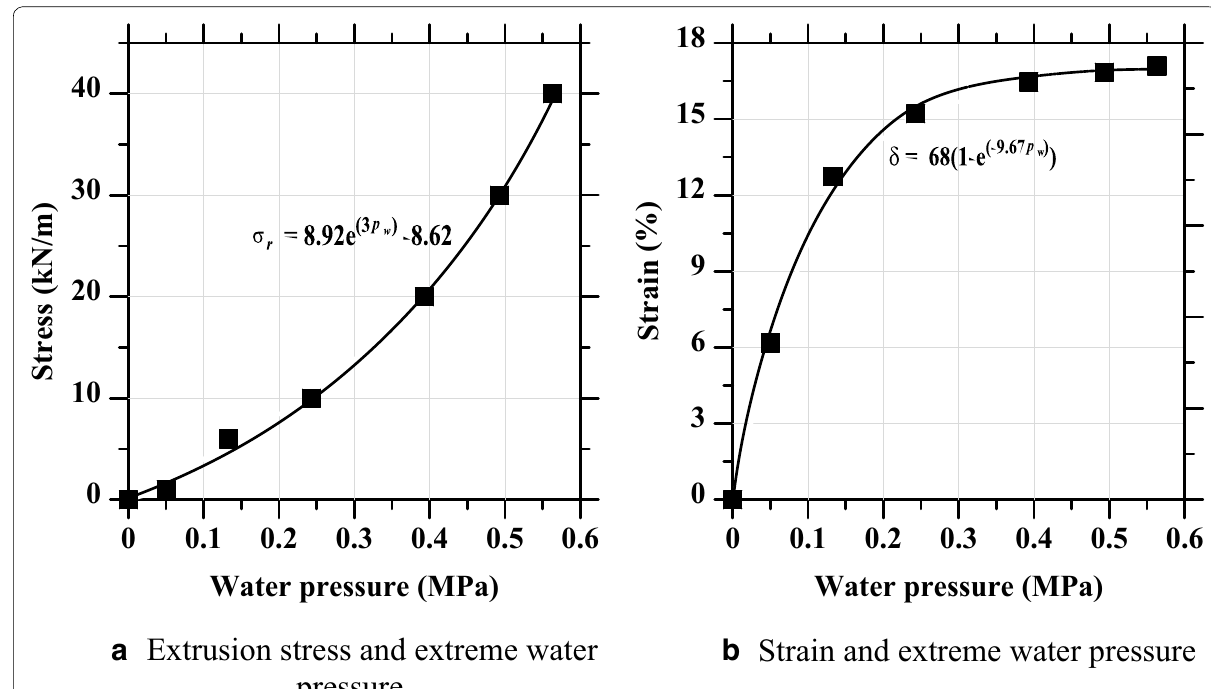
Fig. 12 Water resistance relationship between: a extrusion stress and extreme water pressure; b strain and extreme water